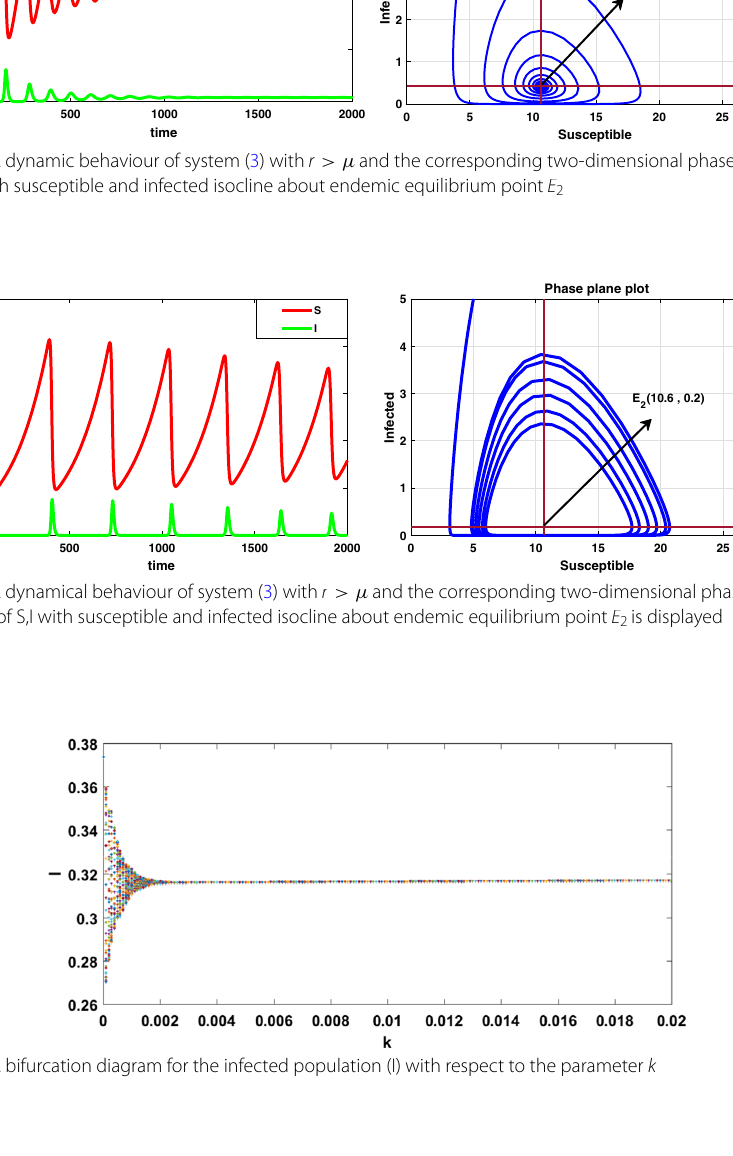
0.15 displayed in Fig. 1. But when the value of infection rate increases, i.e. β = , the value 4.8 > 1 and hence E 0 becomes saddle-node so the system is unstable. Now, the of R 0 = system 3.1 undergoes a forward bifurcation by theorem 8.2, and the dynamical behav- 1 iour is depicted in Fig. 2. When R 0 > , system (3) admits an endemic equilibrium point E 1 and is always asymptotically stable by theorem 8.3, and the dynamical behaviour of the system is shown in Fig. 3. In this case, we have also observed the dynamical behaviour of system (4) is same as system (3).